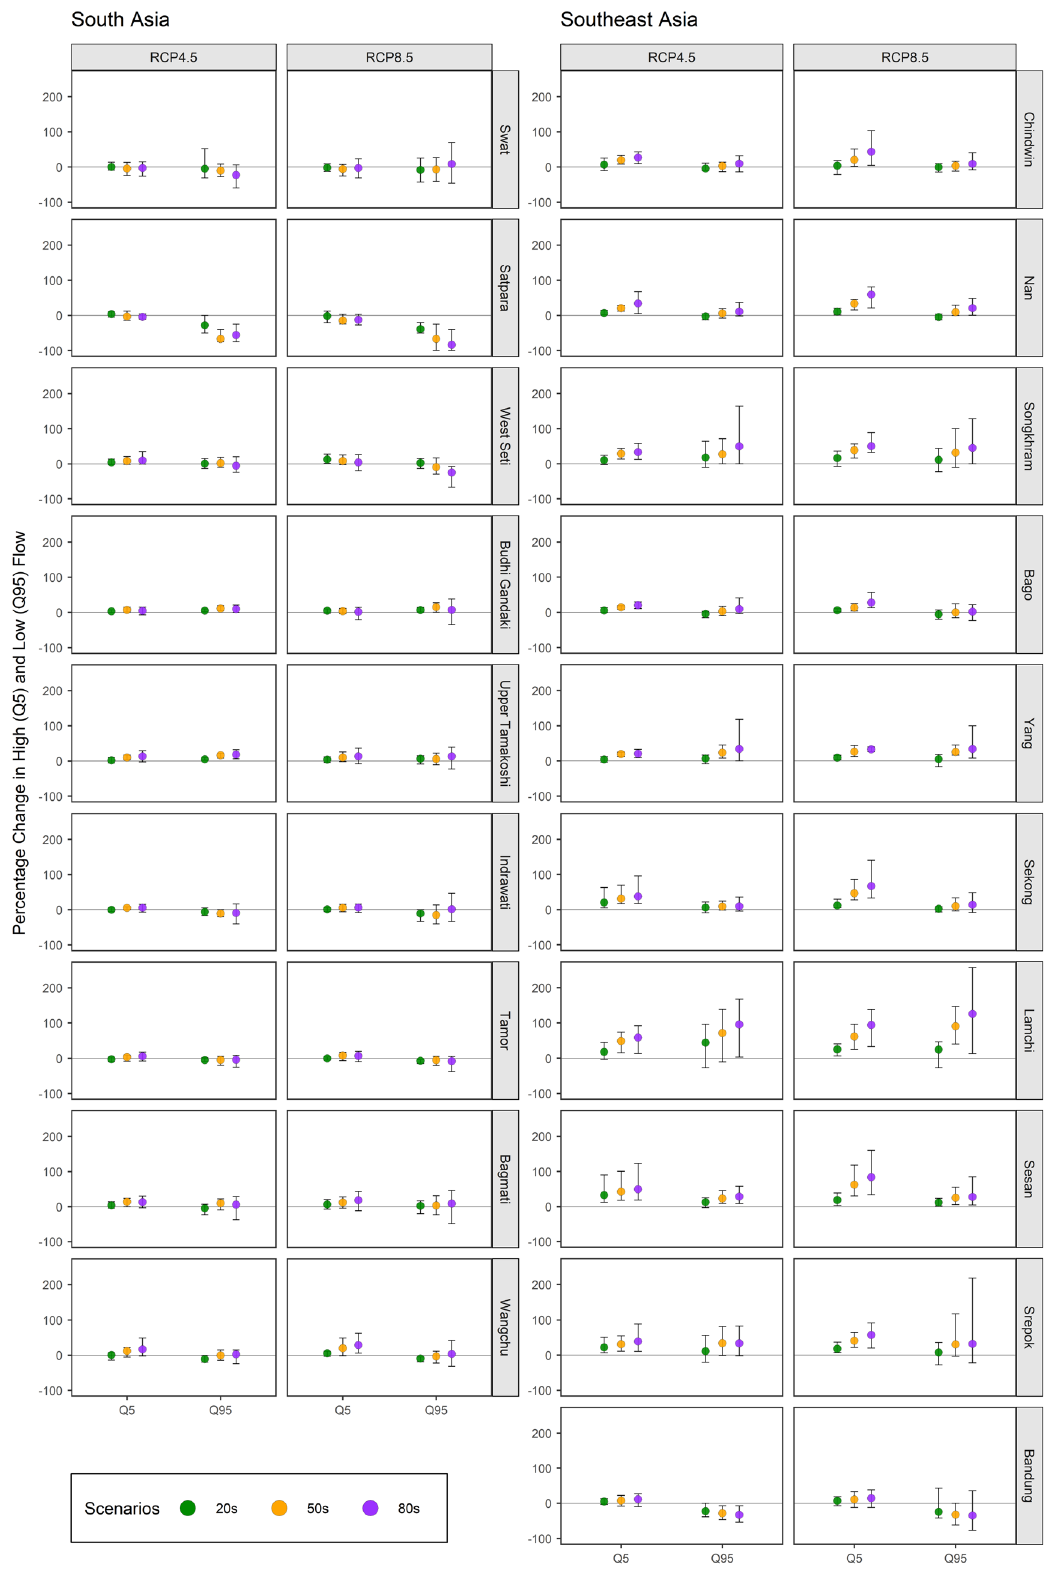
Figure 5. High (Q5) and low flow (Q95) anomaly (% change) in South Asian and Southeast Asian river basins. Each facet corresponds to a different emission scenario (RCP4.5 or RCP8.5) in different basins as indicated at the top and left side of the chart, respectively. The error bar represents the minimum and maximum value among GCMs while the point represents the mean value 20,22